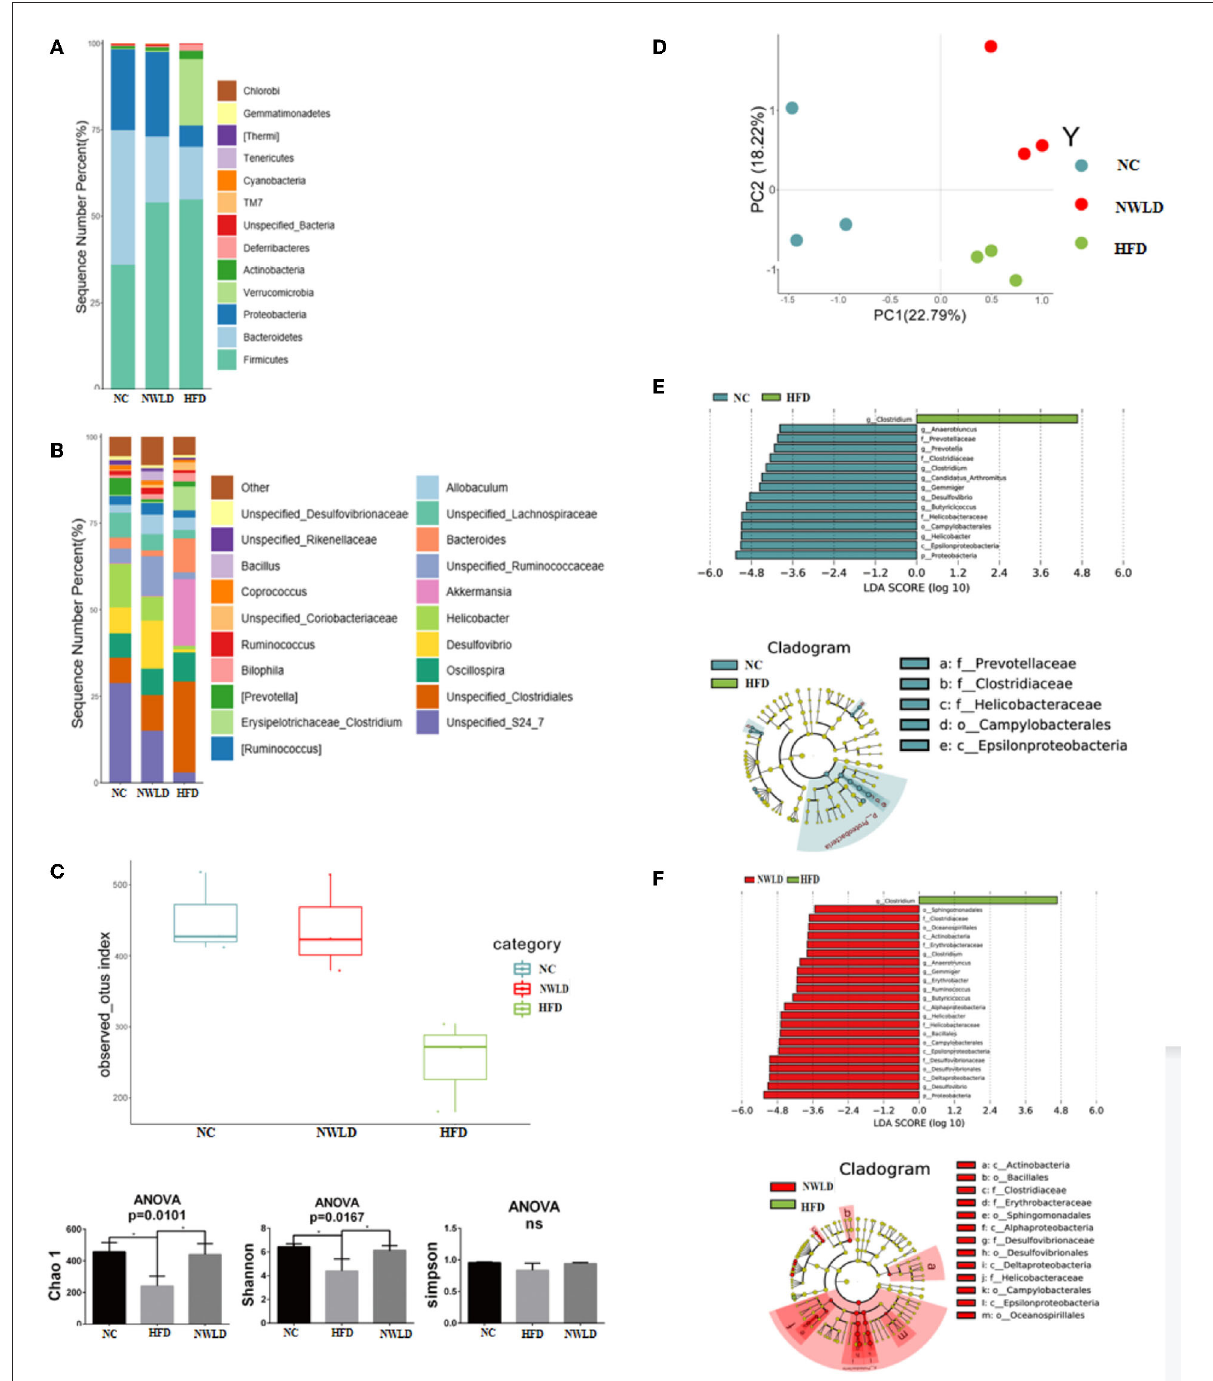
FIGURE2 Characteristics of the gut microbiota in different groups. (A) Histograms of the relative distribution of groups at the phylum level (top 20 species in relative abundance); (B) histograms of the relative distribution of groups at the genus level (top 20 species in relative abundance); (C) alpha diversity. Box plots of observed OTUs, histogram of Chao1, Shannon, and Simpson indices. ANOVA, * p < 0.05; ns, no significance. (D) Beta diversity; (E) LEfSe analysis LDA histograms (LDA score > 2.0) and cladogram of characteristic microorganisms (the NC group compared to group HFD). Kruskal–Wallis test, * p < 0.05. LDA, each transverse column represents a species; the length of the column represents the LDA score, where a higher LDA score indicates a greater difference. The color of the bar indicates the species group. Layers from the inside to outside of the cladogram correspond to different classification levels, i.e., kingdom, phylum, class, order, family, and genus, and the lines between levels represent relationships. Each circular node represents a species. Yellow nodes indicate no significant difference between groups; non-yellow nodes indicate that the species is a characteristic microorganism of the corresponding group (with significantly higher abundance in this group). The shaded fans mark the subclassification interval of the characteristic microorganism. (F) LEfSe analysis LDA histograms (LDA score > 2.0) and cladogram of characteristic microorganisms (group NWLD compared to group HFD). Kruskal–Wallis test, * p <